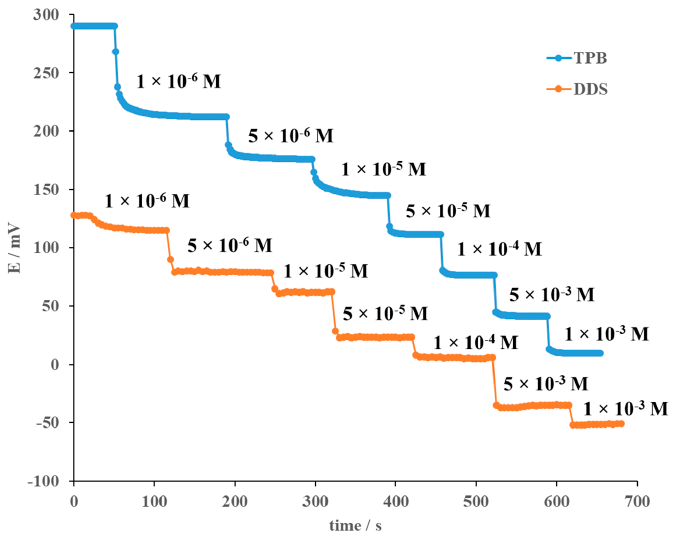
Figure 1. Dynamic response characteristics of the DHBI–TPB surfactant sensor towards TPB and DDS anions established by the addition of a determined concentration of selected anions.